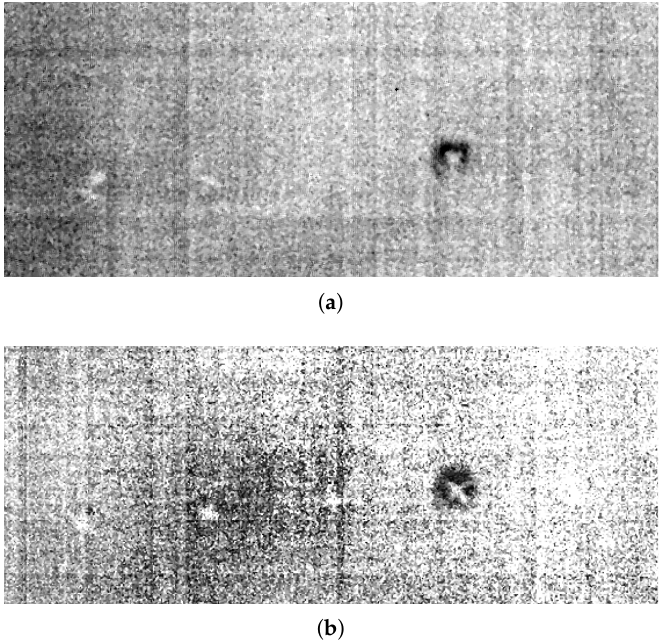
Figure 10. The amplitude ( a ) and phase image ( b ) of area II for a frequency range of 110kHz to 120kHz and a periodicity of τ = 5s. The dark spot in both images corresponds to the screw with the loose